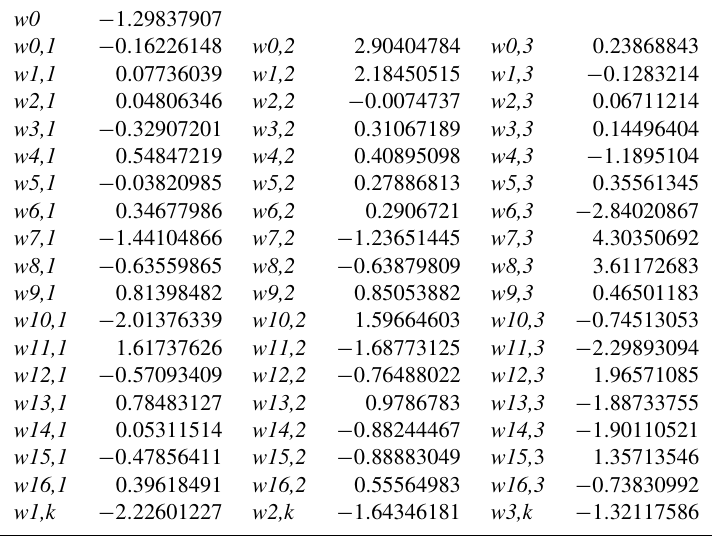
Table A1. The optimised weights w .